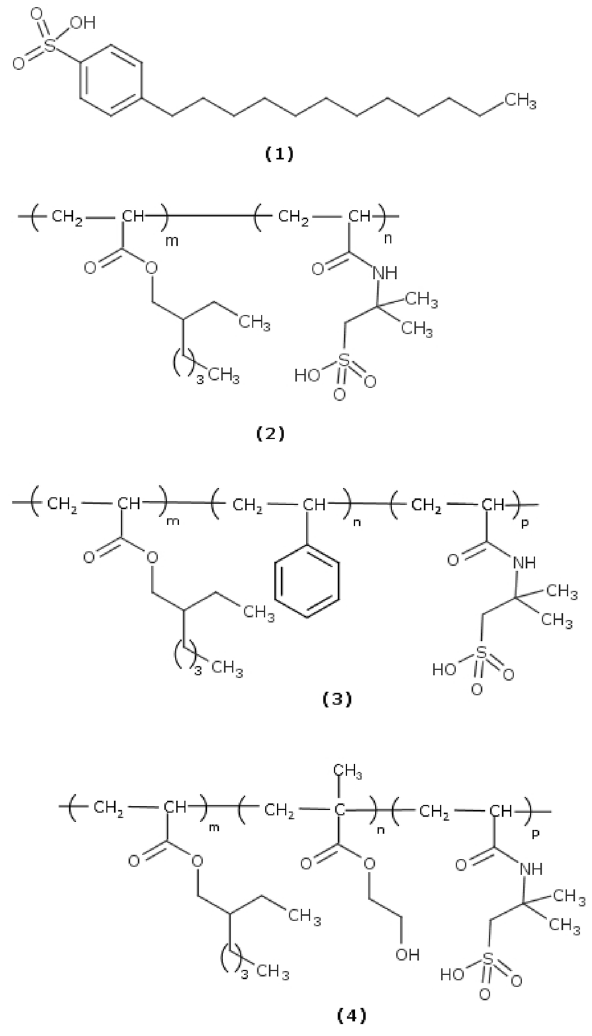
Fig. 10 Chemical structures of some monomeric, copolymeric and terpolymeric naphthenate